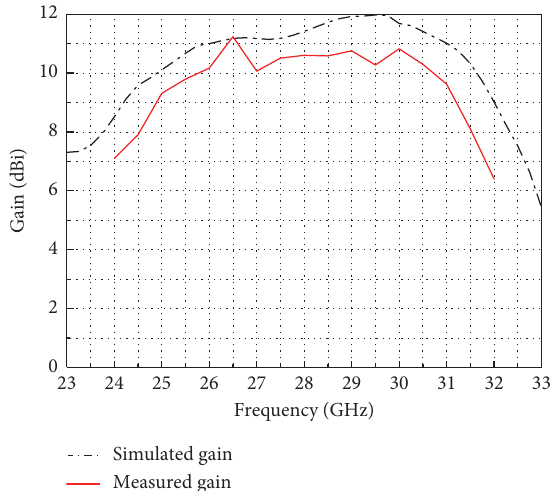
Figure 11: Simulated and measured gains of the proposed array.